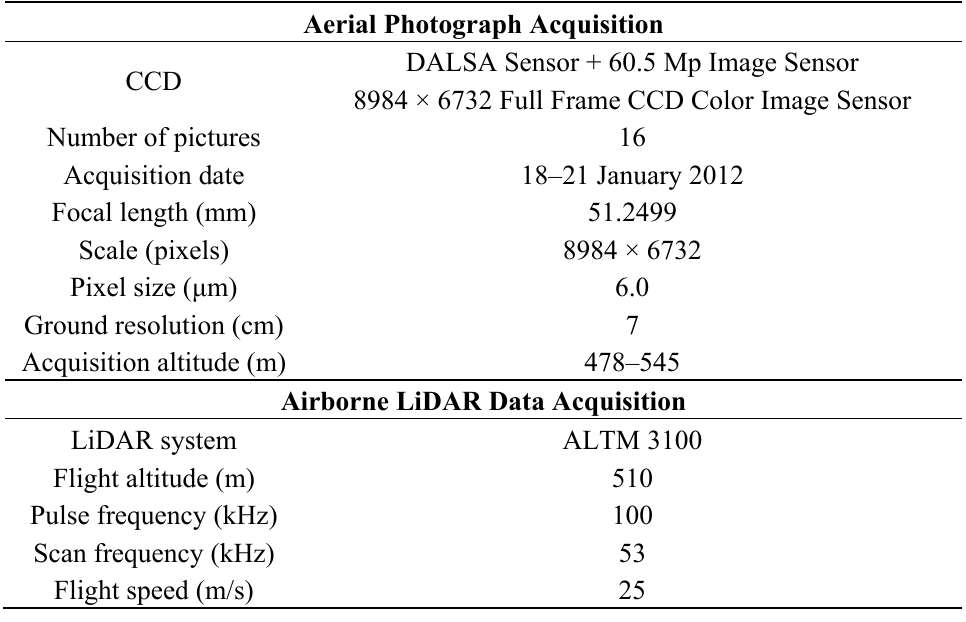
Table 1. Details of aerial photograph and airborne LiDAR data